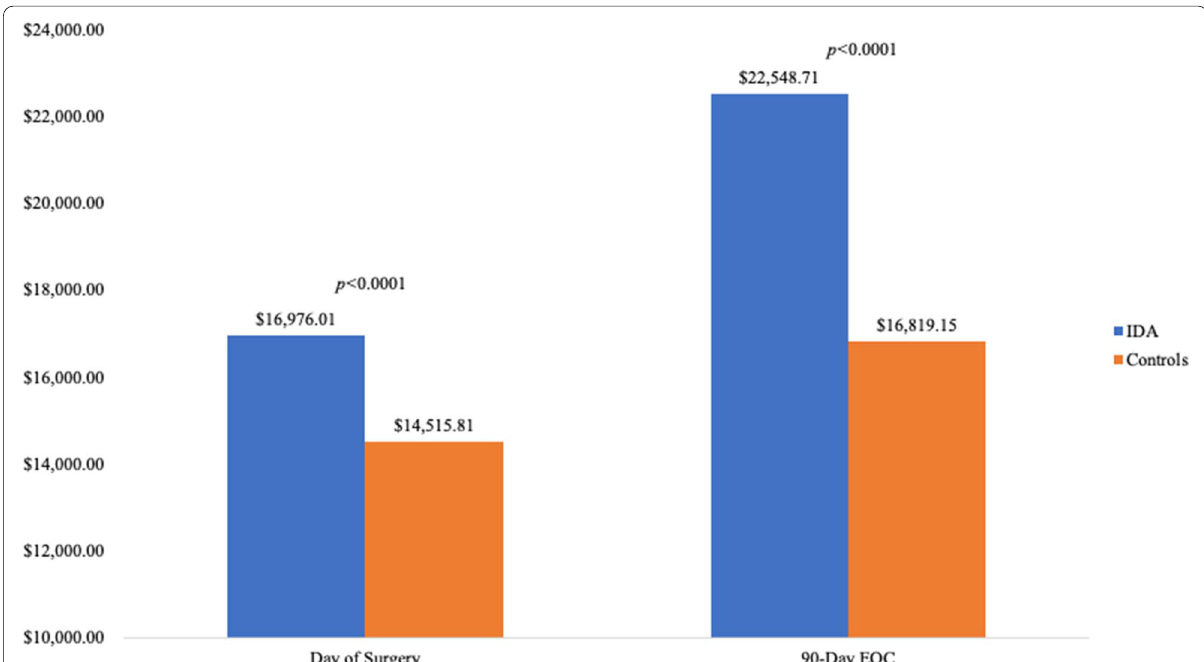
Fig. 1 Comparison of day of surgery and total global 90-day episode of care costs amongst iron deficiency anemia patients undergoing revision total knee arthroplasty. EOC Episode of Care; IDA Iron Deficiency Anemia = =